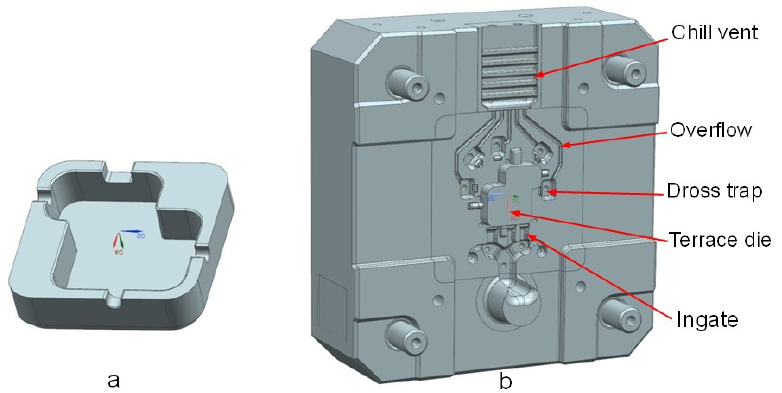
Figure 1. Three-dimensional models of the sample and the corresponding moving die: ( a ) an ashtray style sample and ( b ) components of the moving